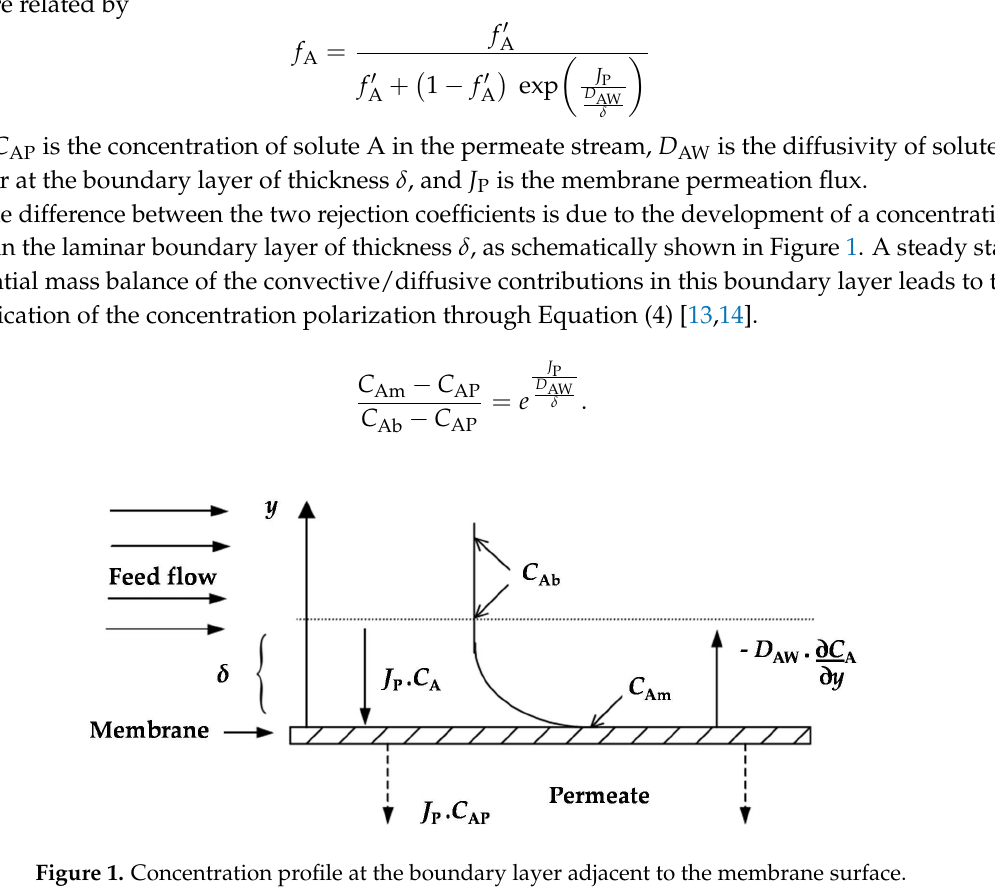
Figure 1. Concentration profile at the boundary layer adjacent to the membrane surface.